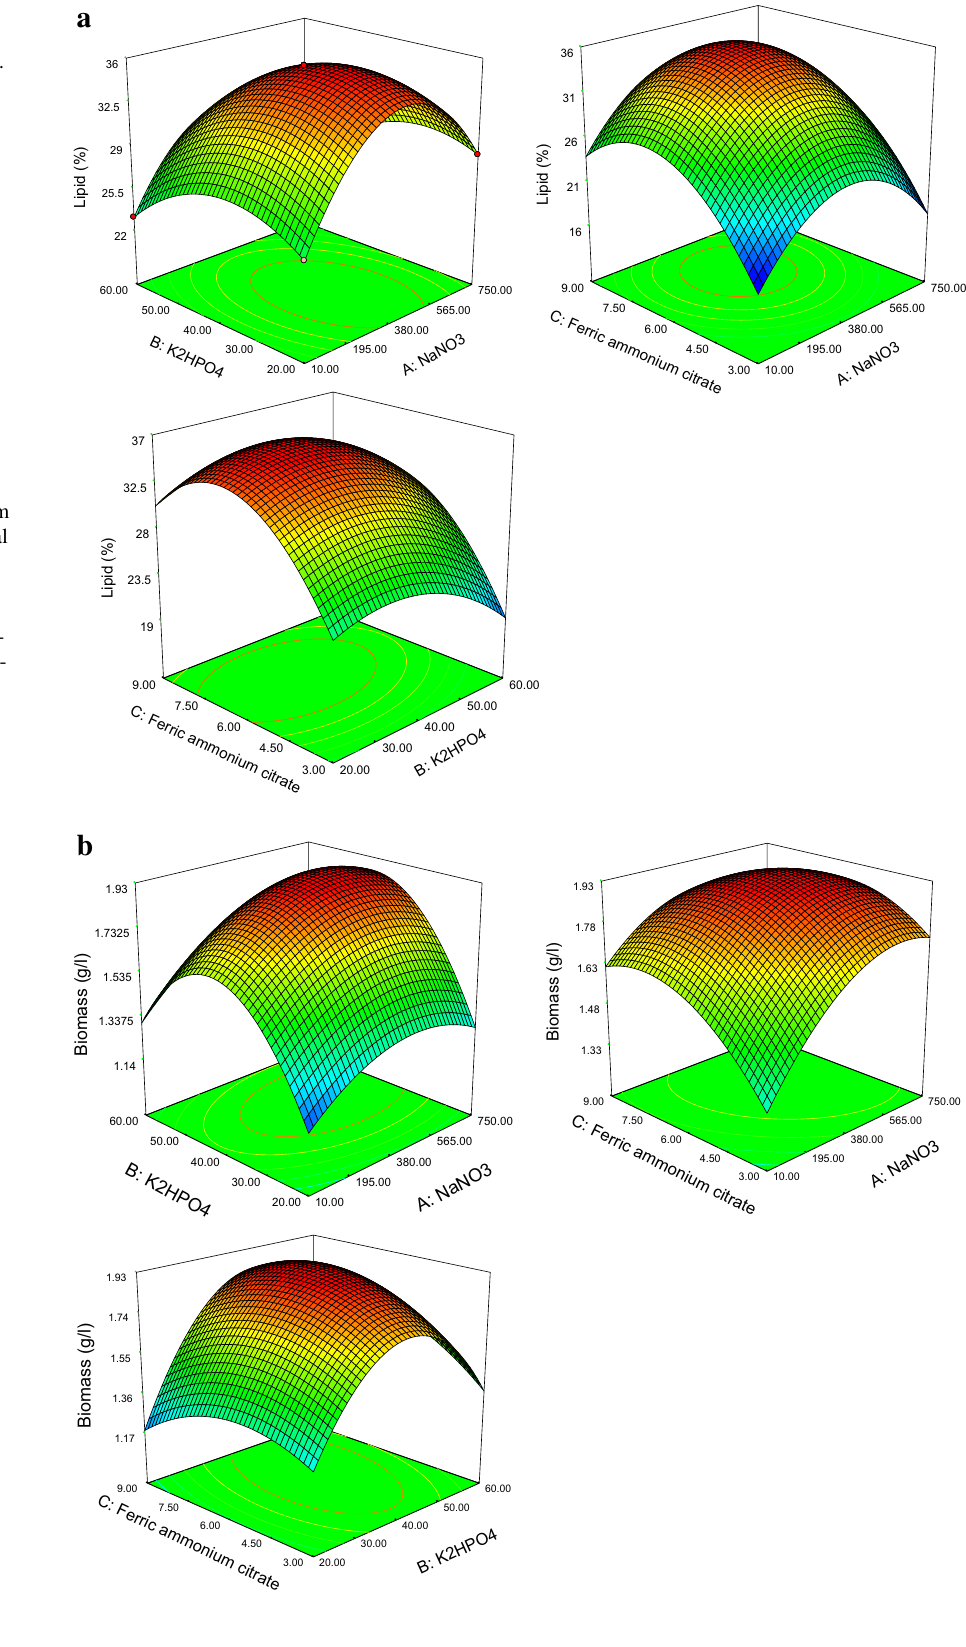
Fig. 4 Normal plots of studen- tized residuals verses normal percentage probability biomass. Three dimensional plot for a biomass (g L −1 ), b lipid accumulation (%), c chloro- phyll (µg mL −1 ), d carbohy- drate (µg mL −1 ) and e protein (µg mL −1 ). A , B Response sur- face graphs for the interactive effect of initial concentration sodium of nitrate, di-potassium hydrogen phosphate and ferric ammonium citrate on lipid % and biomass yield g L −1 in Chlorella Pyrenoidosa . C , D Response surface graphs for the effect interactive of initial sodium nitrate concentra- tion, di-potassium hydrogen phosphate and ferric ammonium citrate on carbohydrate and total chlorophyll content (µg mL −1 ) in Chlorella pyrenoidosa . E Response surface graphs for interactive the effect initial con- centration of Sodium nitrate, di- potassium hydrogen phosphate and ferric ammonium citrate on protein content mg mL −1 in Chlorella